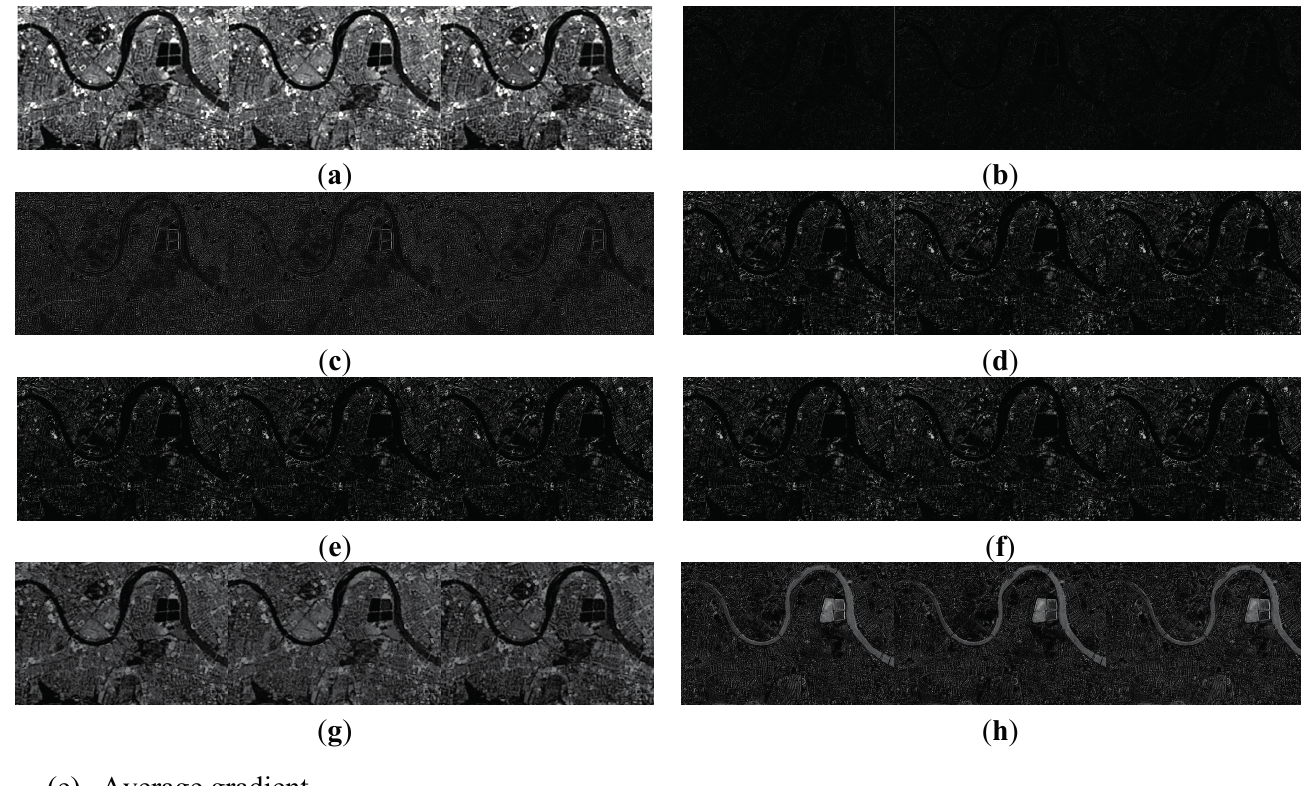
Figure 9. Results of image error analysis (all in grayscale representation and R/G/B sequence from left to right). ( a ) Original image. ( b ) EI of BEMD image. ( c ) EI of Wavelet image. ( d ) EI of IHS image. ( e ) EI of PCA image. ( f ) EI of Brovey image. ( g ) Gaussian high-pass spatial filter fused image. ( h ) Laplacian pyramidal decomposition